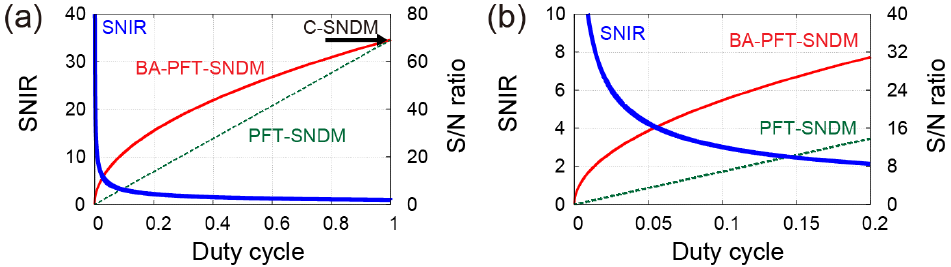
Figure 4. SNIR and comparison of S/N ratios in BA-PFT-SNDM and PFT-SNDM under typical measurement parameters. ( b ) magnifies ( a ) in the range of duty cycle from 0 to 0.2.